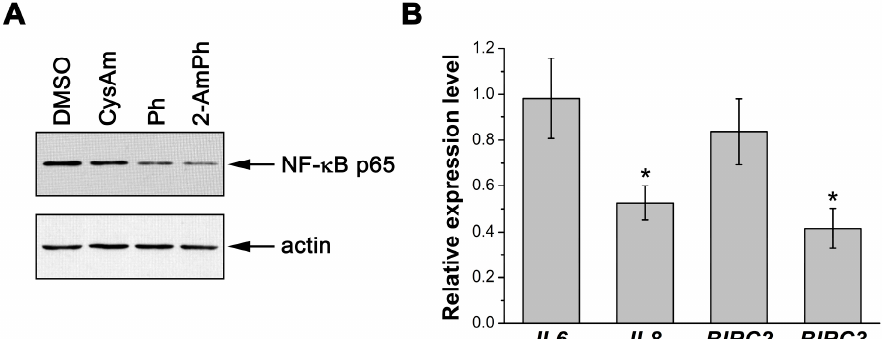
Figure 3. Disturbance of NF- κ B function by 2-AmPh . ( A ) Decrease in the nuclear levels of p65 subunit of NF- κ B revealed by the immunoblotting with anti-p65 antibody of nuclear extracts of cells treated with the vehicle, 2-AmPh and NICs bearing cysteamine ( CysAm ) and phenylthiyl ( Ph ) ligands. ( B ) Expression of NF- κ B target genes after 6 h exposure to 2-AmPh relative to the control (0.1% DMSO) levels, * p < 0.05.